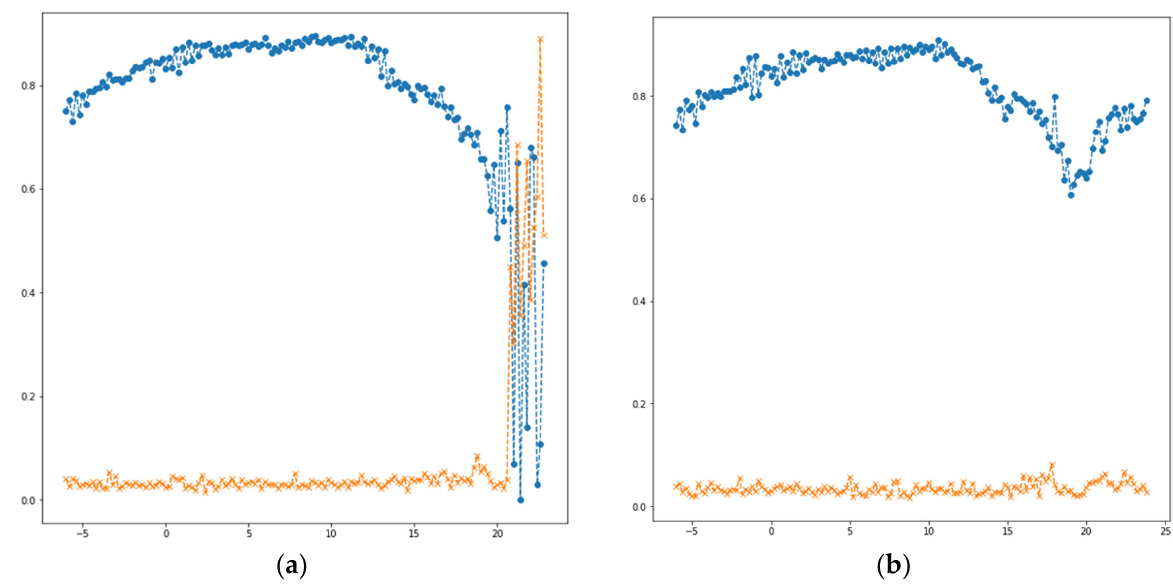
Figure 17. Valid points ratio (blue points) and deviation of estimated yaw angle (orange points) versus the x-coordinate of the robot in the simulation. As the robot approaches the end of the row (x gets closer to 25 m), more and more points from the neighboring block enter the FOV of the camera. ( a ) Simulated configuration II: slanted rows. Since the vines are not aligned, the points measured by the Lidar from the neighboring rows do not match the sensor template of the current block rows; hence, the valid points ratio and the yaw angle deviation change drastically. The row-end detection method is successful. ( b ) Simulated configuration I: parallel, aligned rows. Since the vines are aligned, and parallel, the points measured by the Lidar from the neighboring rows match the sensor template of the current block rows well. Hence, the valid points ratio and the yaw angle deviation do not change significantly. The row-end detection method fails.